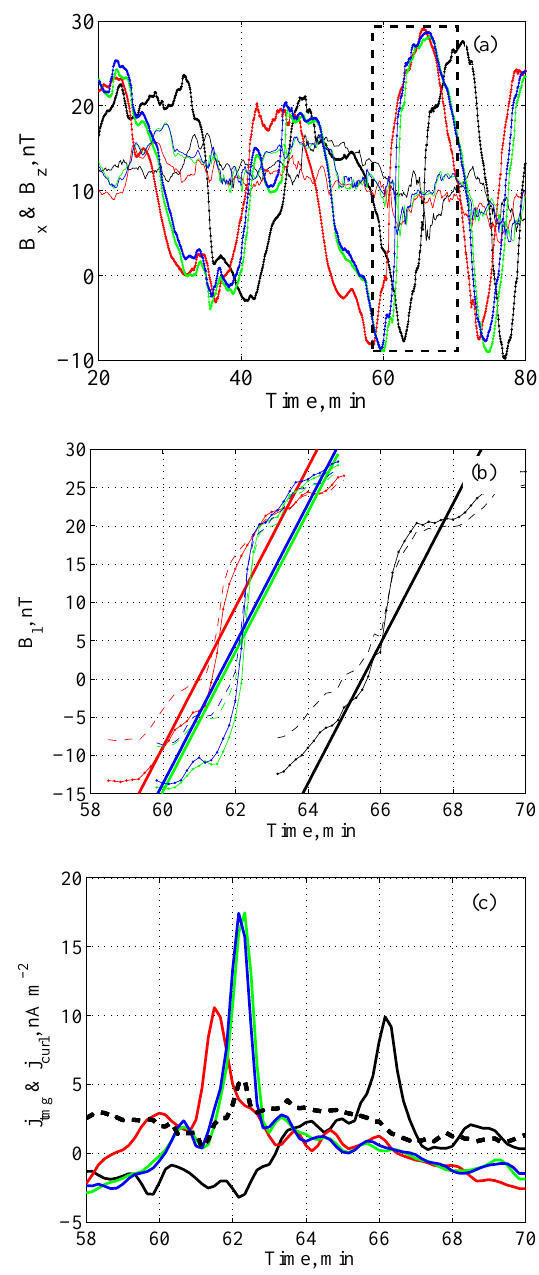
Figure 1. Data from 28 July 2005 starting from 23:00UTC. (a) B x (dots) and B z (solid lines) fields in the series. The dash-bounded domain shows the example CS crossing. (b) Approximation of B l field used for calculation of time delays for the fourth cross- ing. (c) Amplitude of current density calculated by the curlome- ter method (dashed line) and the timing method j tmg (solid lines for four spacecraft). Cluster spacecraft colours are black (1sc), red (2sc), green (3sc), and